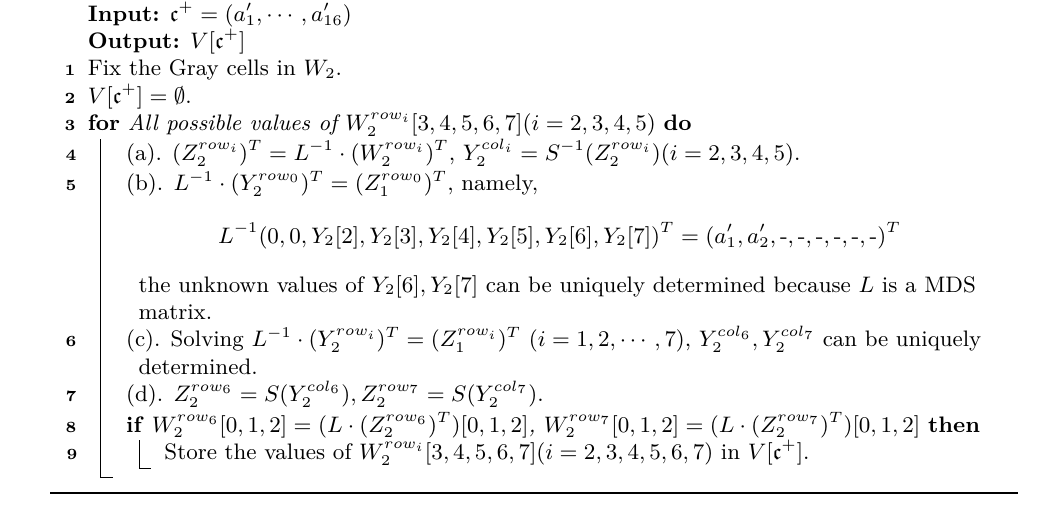
Algorithm 5: Compute the solution space of Blue neutral cells in Figure